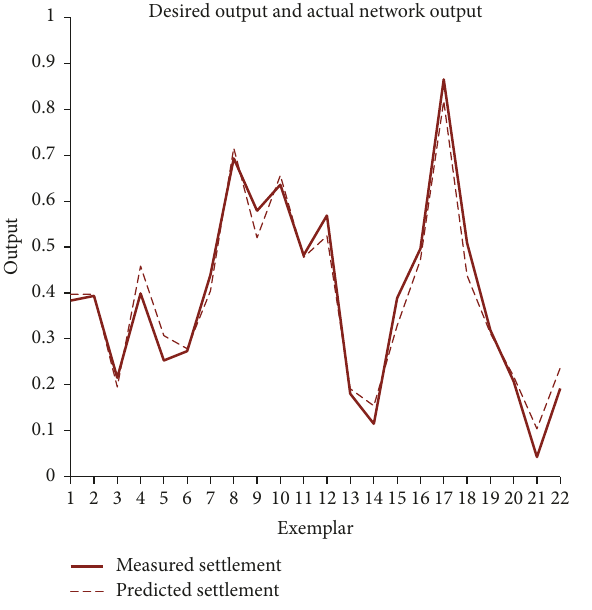
Figure 19: Predicted settlements versus calculated ones for the best static neural network, 5-3-12-1.